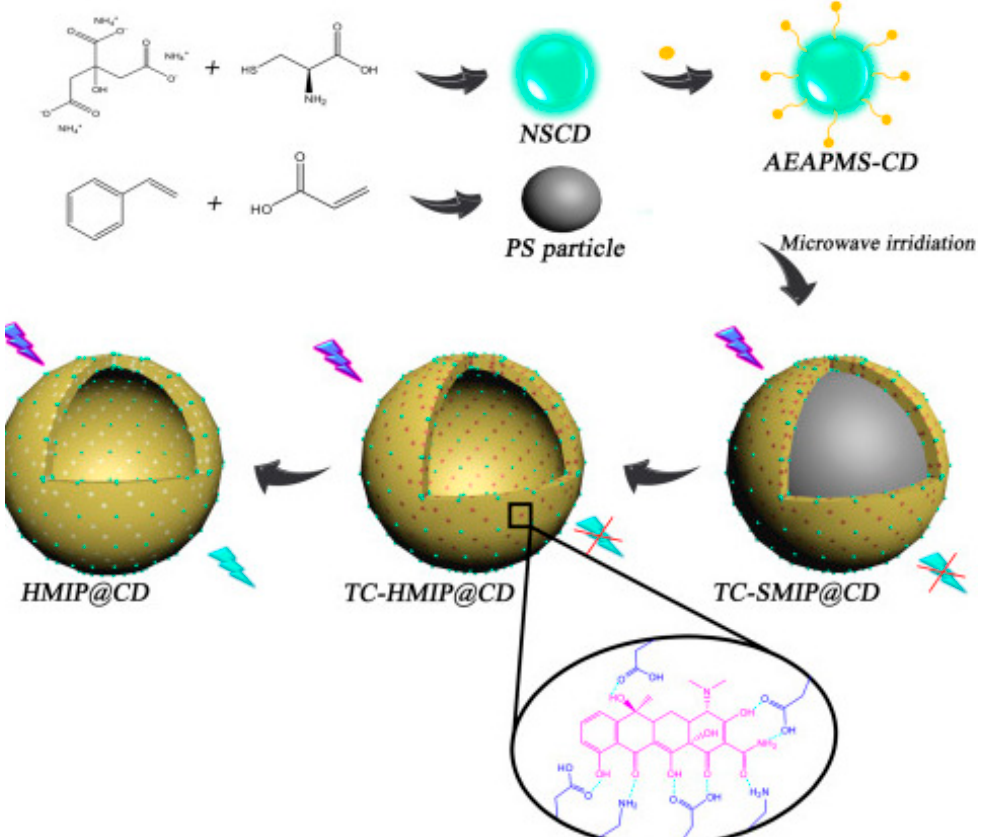
Figure 4. Schematic illustration for preparation of HMIP@CD. Reprinted with permission from [80]. Copyright (2018) Elsevier.